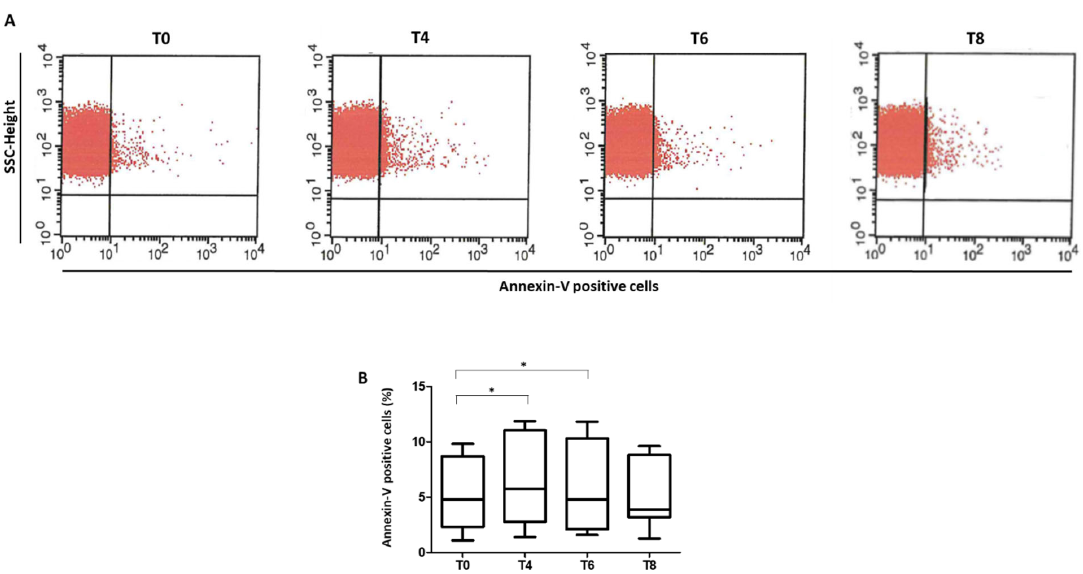
Figure 5. Annexin V positive RBCs. RBCs were analyzed by flow cytometry after staining with PE- conjugated annexin V. ( A ) Representative dot-plot graph of RBCs isolated from prediabetic patients. ( B ) Quantitative analysis of annexin V RBCs. Data are expressed as percent of positive RBCs ± SD. 𝑛 = 11; * p < 0.05.